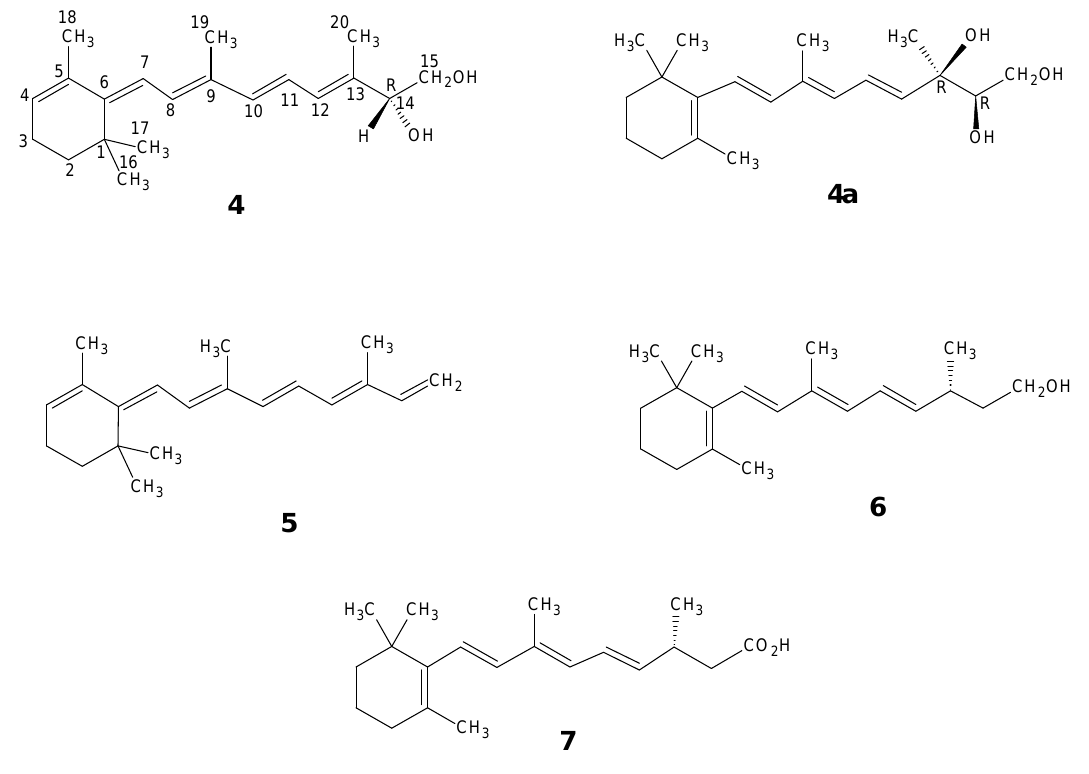
Figure 1. The structures of (14 R )-14-hydroxy-4,14- retro -retinol 4 , (13 R ,14 R )-13,14- dihydroxyretinol 4a , 4,5-didehydro-15,5- retro -deoxyretinol or anhydroretinol 5 , (13 R )- 13,14-dihydroretinol 6 and (13 R )-13,14-dihydroretinoic acid 7 . The IUPAC numbering is given in the structure 4